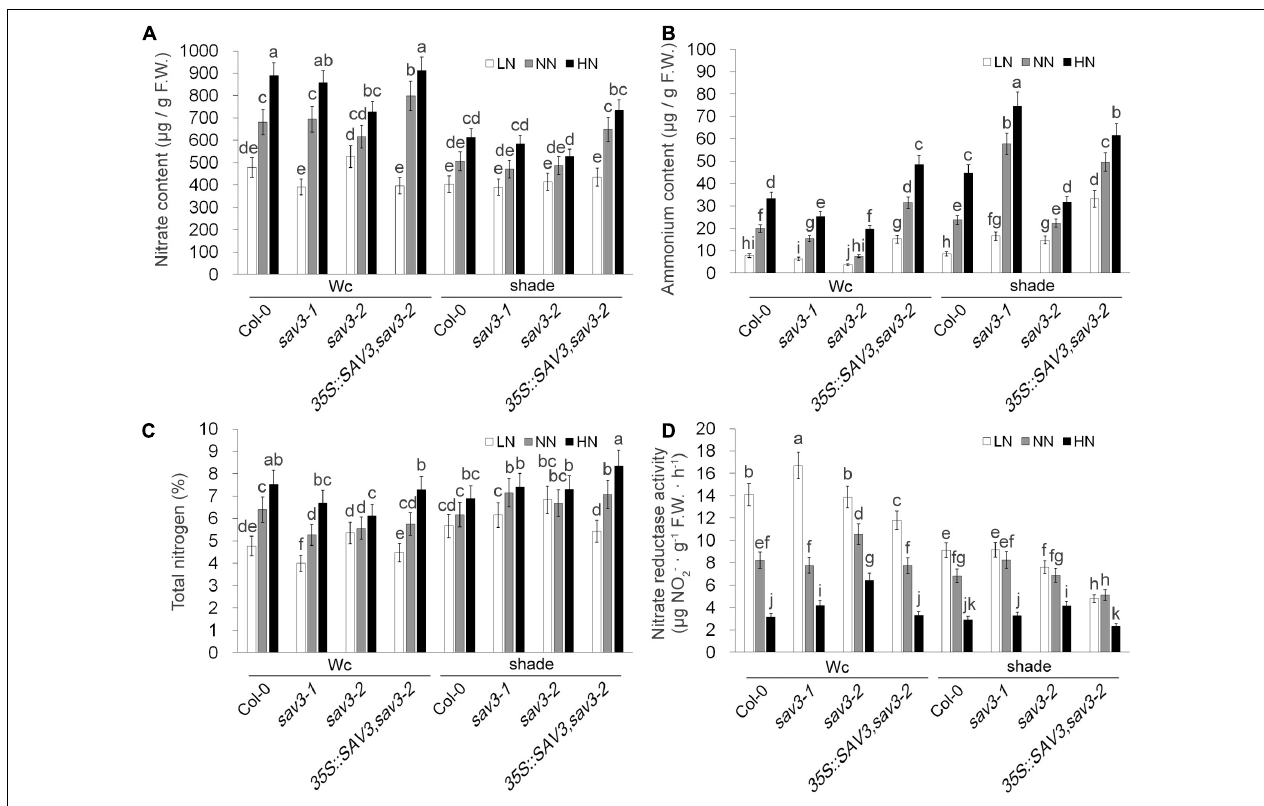
FIGURE 7 | Shade avoidance 3 mediates N-regulated and shade-regulated nitrogen assimilation. Nitrate content (A) , ammonium content (B) , total N content (C) and nitrate reductase activity (D) of 14-day-old seedlings grown under different N levels with or without shade treatment were determined. F.W., fresh weight; Wc, continuous white light; LN, low N condition; NN, normal N condition; HN, high N condition. Bars represent standard deviations of three independent replicates. Values followed by different letters are significantly different at P < 0.05 according to Duncan’s multiple range